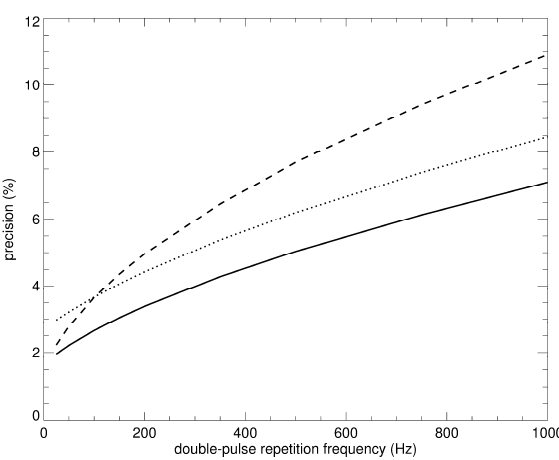
Figure 5. XCO 2 and XCH 4 precision at sea level as function of laser pulse repetition frequency (PRF) for CO 2 at 1.57 (solid) and 2.05 (dashed) µm and for CH 4 at 1.65 µm (dotted) under the conditions of Tables 1 and 2.